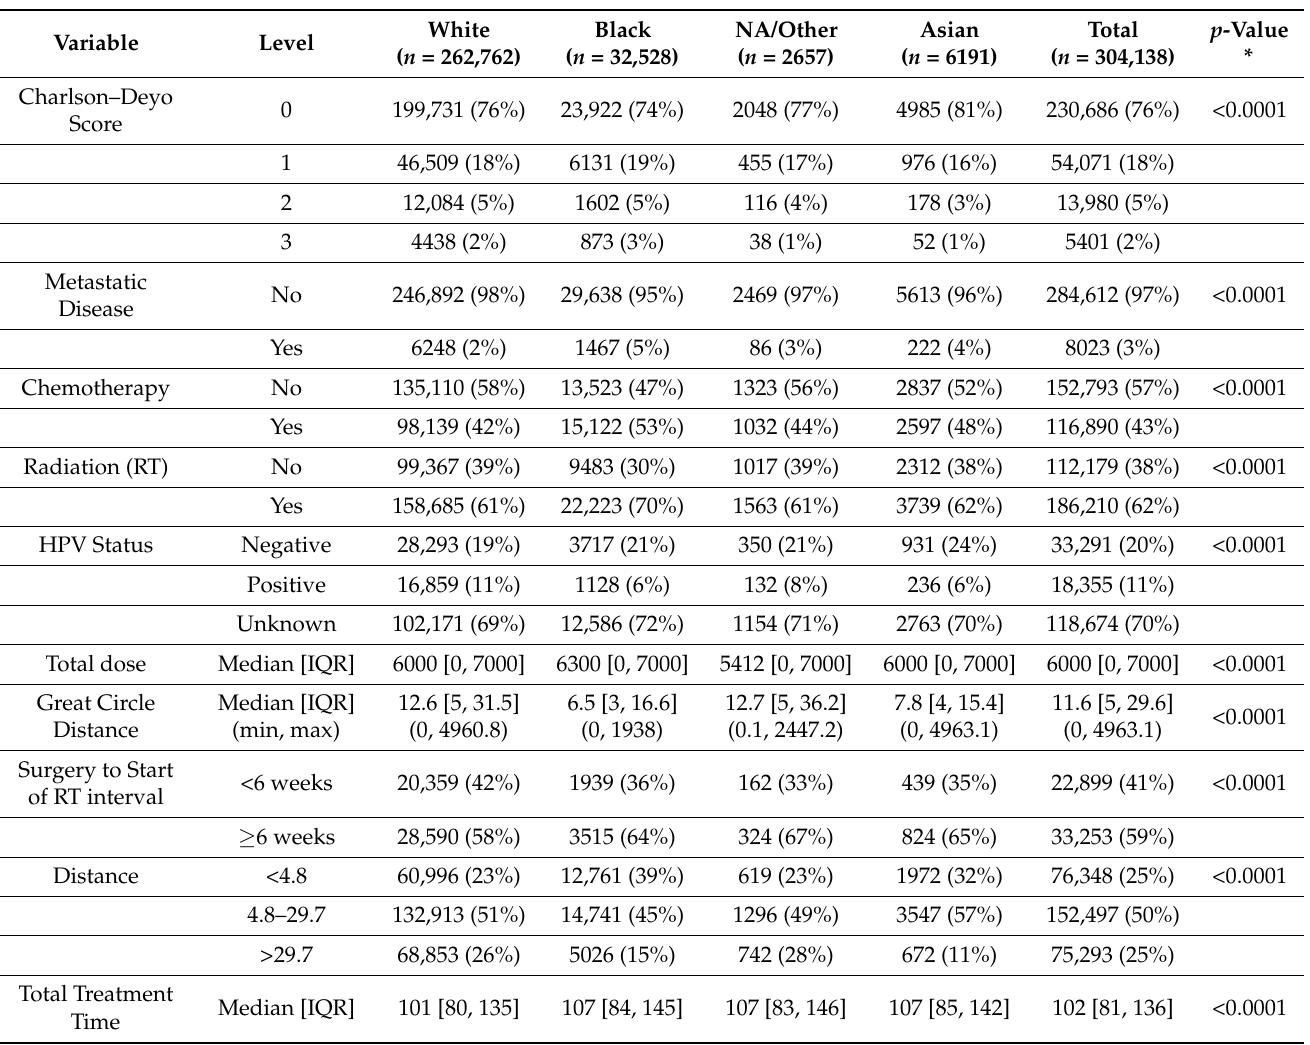
(Figure 2A). When comparing White vs. non-White patients for all subsites, non-White patients had an inferior 5-year OS of 42.1% vs. 51.2% (Figure 2B; p < 0.0001). The 5-year OS for Black-Hispanic vs. Black non-Hispanic patients was 49% vs. 38% (Figure 2C, Log-rank p < 0.0001). The 5-year OS for White Hispanic vs. White non-Hispanic was 51.5% versus 51.4% ( p = 0.511). Across all clinical AJCC stage groups, Asian patients had the best 5-year OS and Black patients had the worst OS (Figure 2D–G). Black patients had an inferior 5-year OS across multiple head and neck subsites, including the hypopharynx, larynx, nasal cavity, nasopharynx, pharynx, and oral cavity (Figure 3, All Log rank p < 0.001). Among the oropharynx HNSCC patients, the 5-year OS rates in p16+ White, Black, and Asian patients were 65.7%, 39.4%%, and 55%, respectively (Supplemental Figure S1A). For HPV-negative patients, the 5-year OS among White and Black patients was 36.5% vs. 13.8% (Supplemental Figure S1B, p < 0.0001). Among Black HNSCC patients, survival was improved for patients with higher incomes, those who had insurance, and those